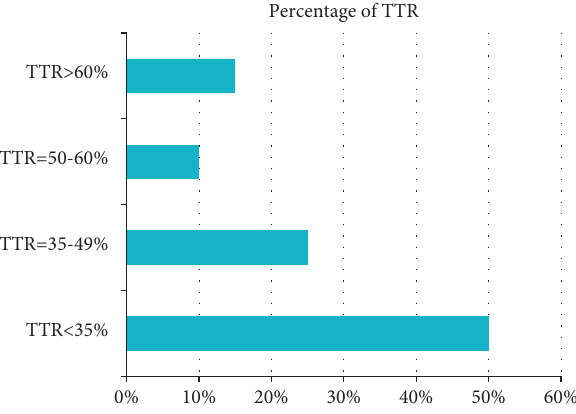
Figure 2: Bar diagram showing the percentage of TTR among patients on